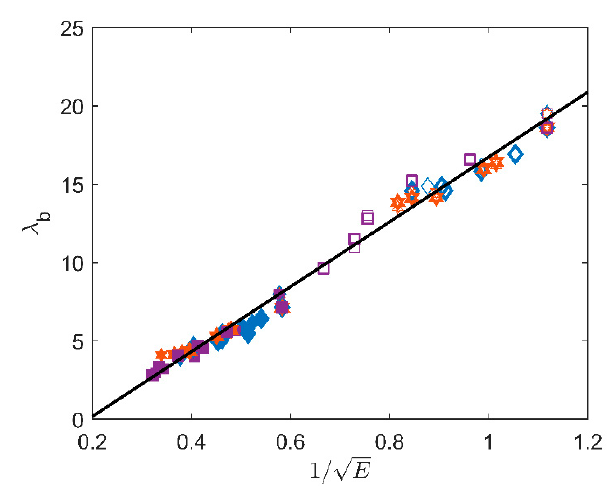
√ E for all samples (filled, unfilled) and Figure 10.  𝒃 versus 𝟏/√𝑬 for all samples (filled, unfilled) and temperatures. Figure 10. λ b versus 1 /